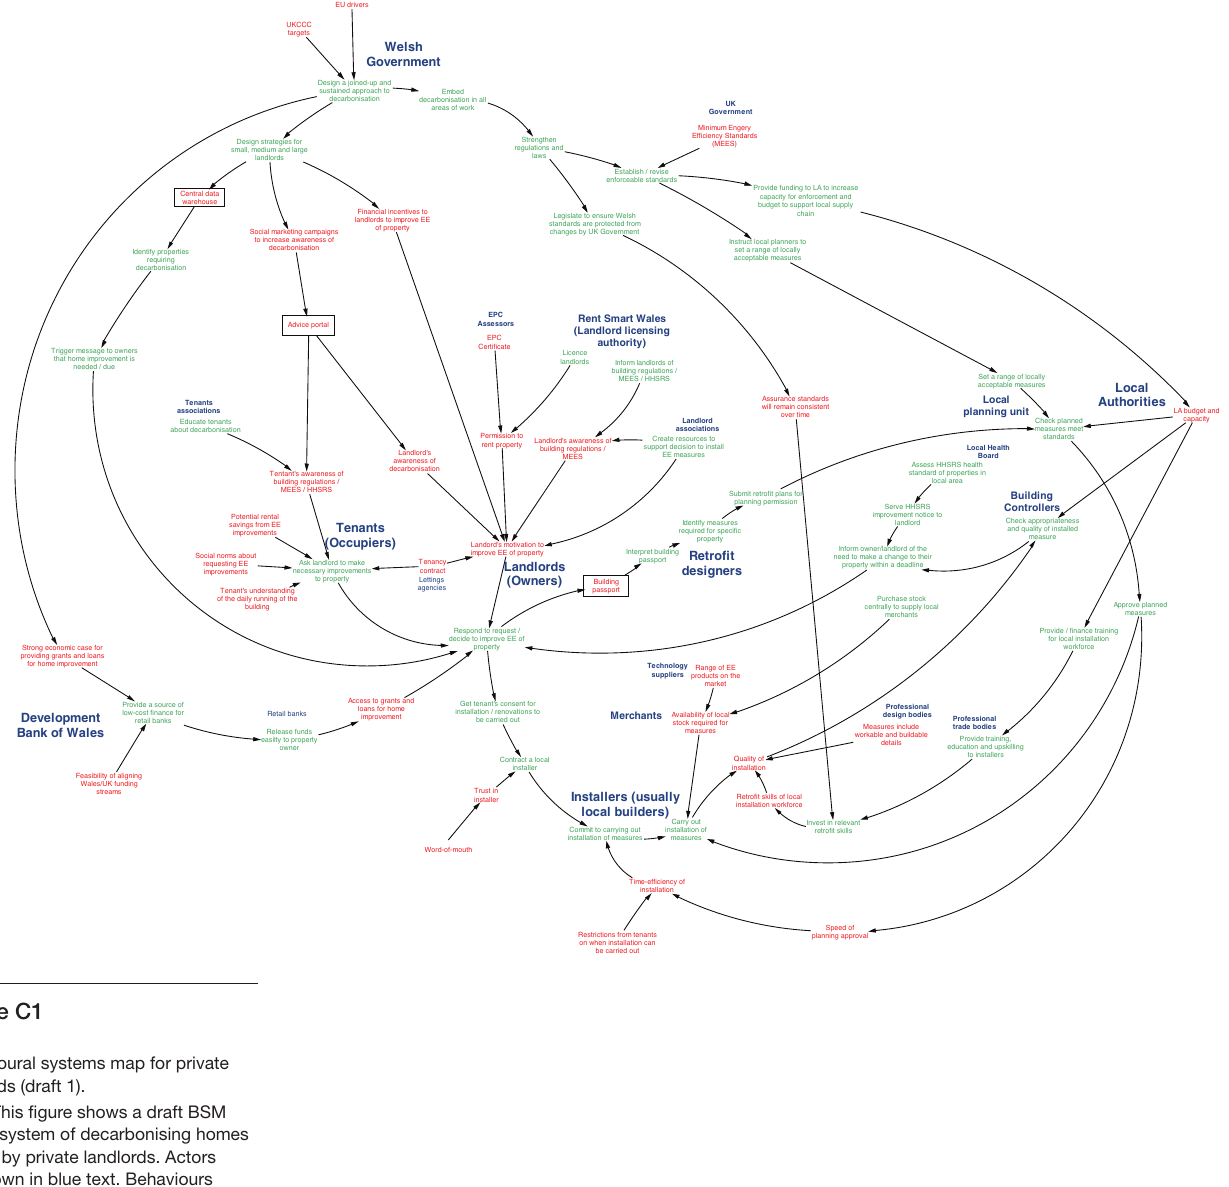
Behavioural systems map for private landlords (draft 1). Note. This figure shows a draft BSM for the system of decarbonising homes owned by private landlords. Actors are shown in blue text. Behaviours are shown in green text. Influences on behaviour are shown in red text. Arrows are used to show positive causal links identified among behaviours and influences on behaviour. Black text boxes are used to show potential new services or resources identified to support decarbonisation. Abbreviations: EE, energy efficiency/ energy efficient; EPC, energy performance certificate; HHSRS, housing health and safety rating system; LA, local authority; MEES, minimum energy efficiency